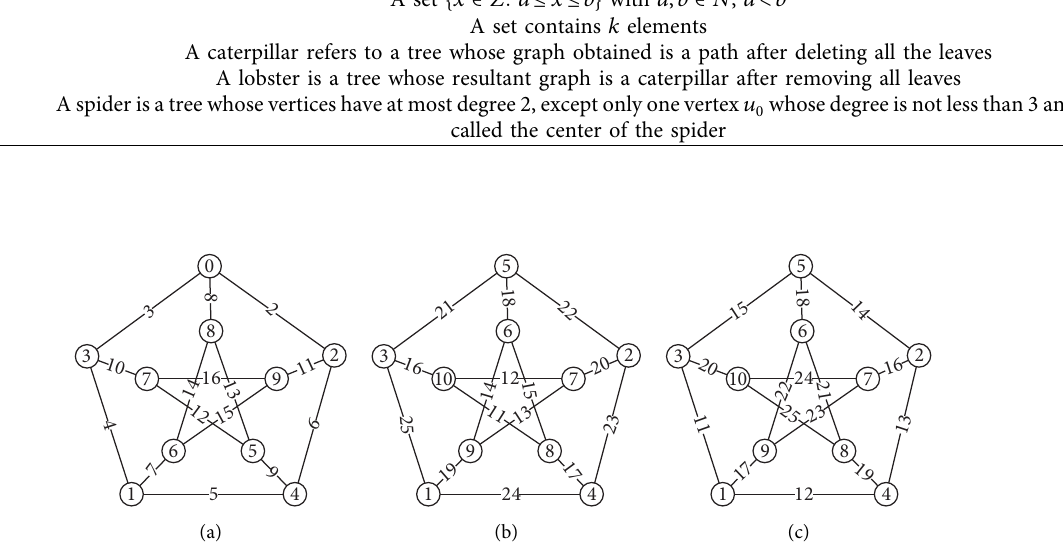
Figure 1: (a) The Petersen graph has a strongly c-elegant labelling. (b) The Petersen graph has SEMT labelling with a magic constant 29. (c) The Petersen graph has a super ( 15 , 2 ) -EAT labelling that is also a super (− 7 , 1 ) -magical labelling.